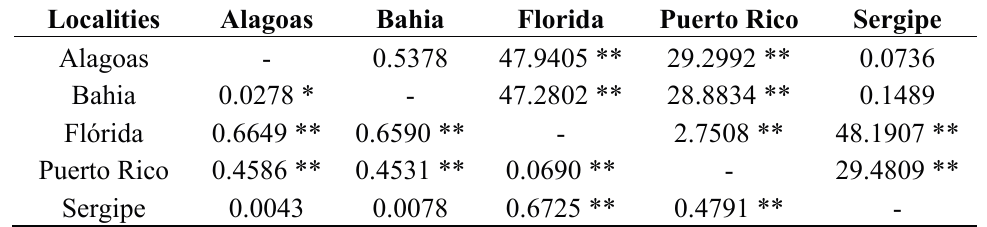
Table 3. Corrected average pairwise difference Da (above diagonal) and F ST (below diagonal) between populations based on 12S + CR mt DNA sequences of C. guanhumi .